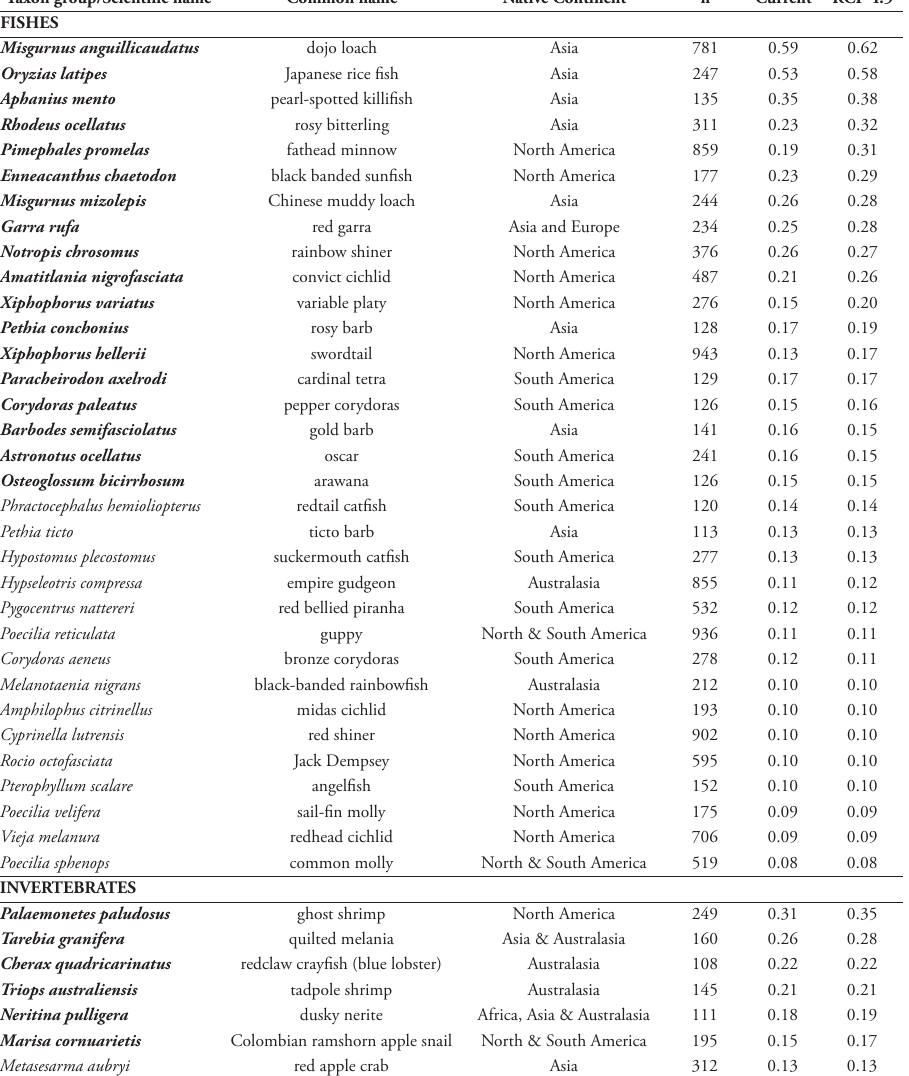
Table 2. Outputs of species distribution models (SDMs), using UK temperatures under current and future climate conditions (i.e. 2050, under Representative Concentration Pathway, RCP 4.5, scenario), for ornamental freshwater fish and invertebrate species identified via eBay and Google searches in addi- tion to expert elicitation as commonly traded in the UK (ordered by decreasing mean RCP 4.5 suitability score, then by mean current day suitability score and then by native continent. Also given is the number of records ( n ) from the Global Biodiversity Information Facility (GBIF; www.GBIF.org) used to carry out the SDMs (after selection of 1000 random points, removal of duplicates and cleaning). Species in bold had a mean suitability score of ≥ 0.15 under RCP4.5 2050 and were therefore subject to pathogen and parasite